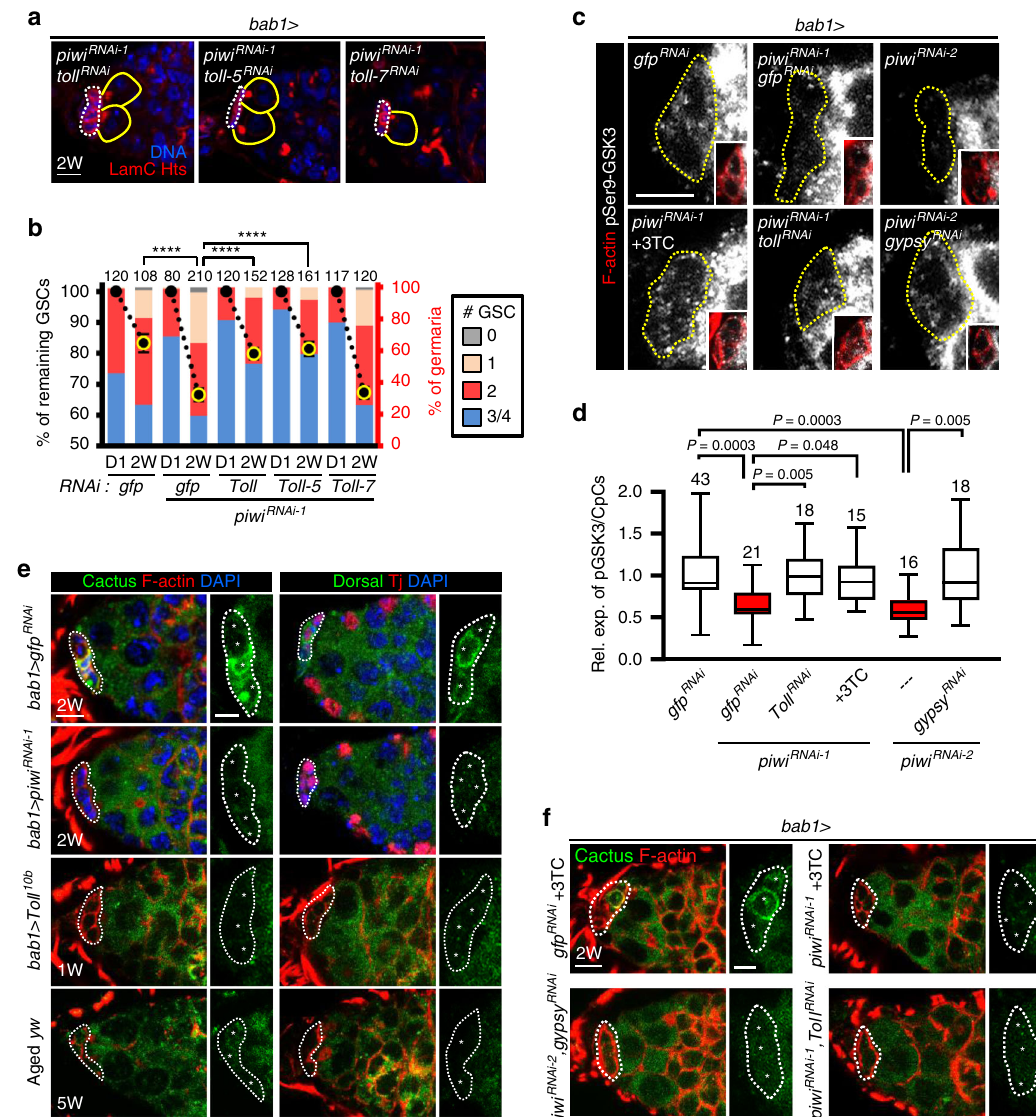
Fig. 4 Decrease of Piwi expression in the niche causes GSC loss via Toll-mediated GSK3 activation. a , b GSC number in 2-week-old germaria of indicated genotypes. Percentage (%) of remaining GSCs at 2W (left y -axis) represents GSC number at 2W normalized to GSC number at D1 of the same genotype. Note that GSC number of gfp RNAi-1 alone and gfp RNAi-2 ; piwi RNAi-1 are the same data as shown in Fig. 1d and Fig. 3j, respectively; % of germaria. Right y -axis indicates the proportion of 2-week-old germaria carrying 0, 1, 2, and 3 or 4 GSCs. Yellow outline on symbols indicates that the % of remaining GSCs is signi fi cantly lower than D0 of the same genotype. Error bars, S.E.M. c , d pSer9-GSK3 β expression in the niche of 2-week-old bab1 > piwi RNAi-1 , bab1 > piwi RNAi-2 , bab1 > piwi RNAi-1 & toll RNAi , bab1 > piwi RNAi-2 & gypsy RNAi and bab1 > piwi RNAi-1 with 3TC treatment (10 mM) germaria (white, pSer9-GSK3 β ; red, F-actin for CpC plasma membranes). Box-whiskers plots ( d ) show the central lines for median values, edges of box represent upper (75th) and lower (25th) quartiles and whiskers show minimum and maximum values. e Cactus (left panel: Cactus, green; red, F-actin; blu e , DAPI) and Dorsal (right panel: Dorsal, green; red, Tj; blue, DAPI) expression in gfp-KD , toll 10 b -expressing, piwi -KD, and aged CpCs of fl ies at indicated age. f Cactus (green; red, F-actin) expression in 3TC treatment of gfp-KD or piwi -KD, and double knockdown gypsy or Toll in CpCs of fl ies at indicated age. Scale bars, 5 μ m for images on left and 2.5 μ m for enlarged images on right. Student ’ s t -test for b and One-way ANOVA for d . **** P < 0.0001. At least two b iological replicates were performed for each